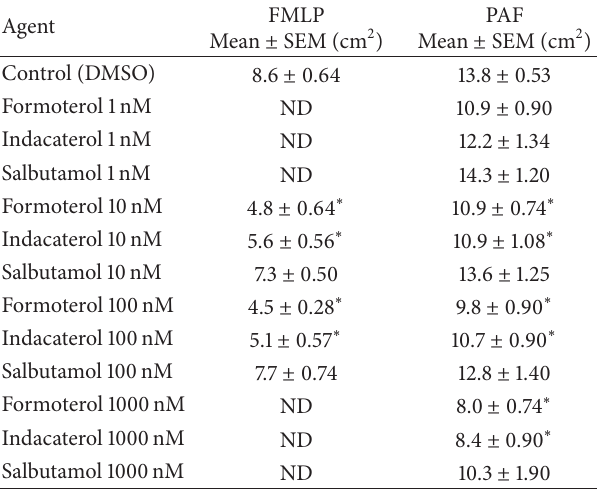
Table 1: Effects of formoterol, indacaterol, and salbutamol (1, 10, 100, and 1000nM) on the cytosolic Ca 2+ concentrations (area under curve) of FMLP- and PAF-activated